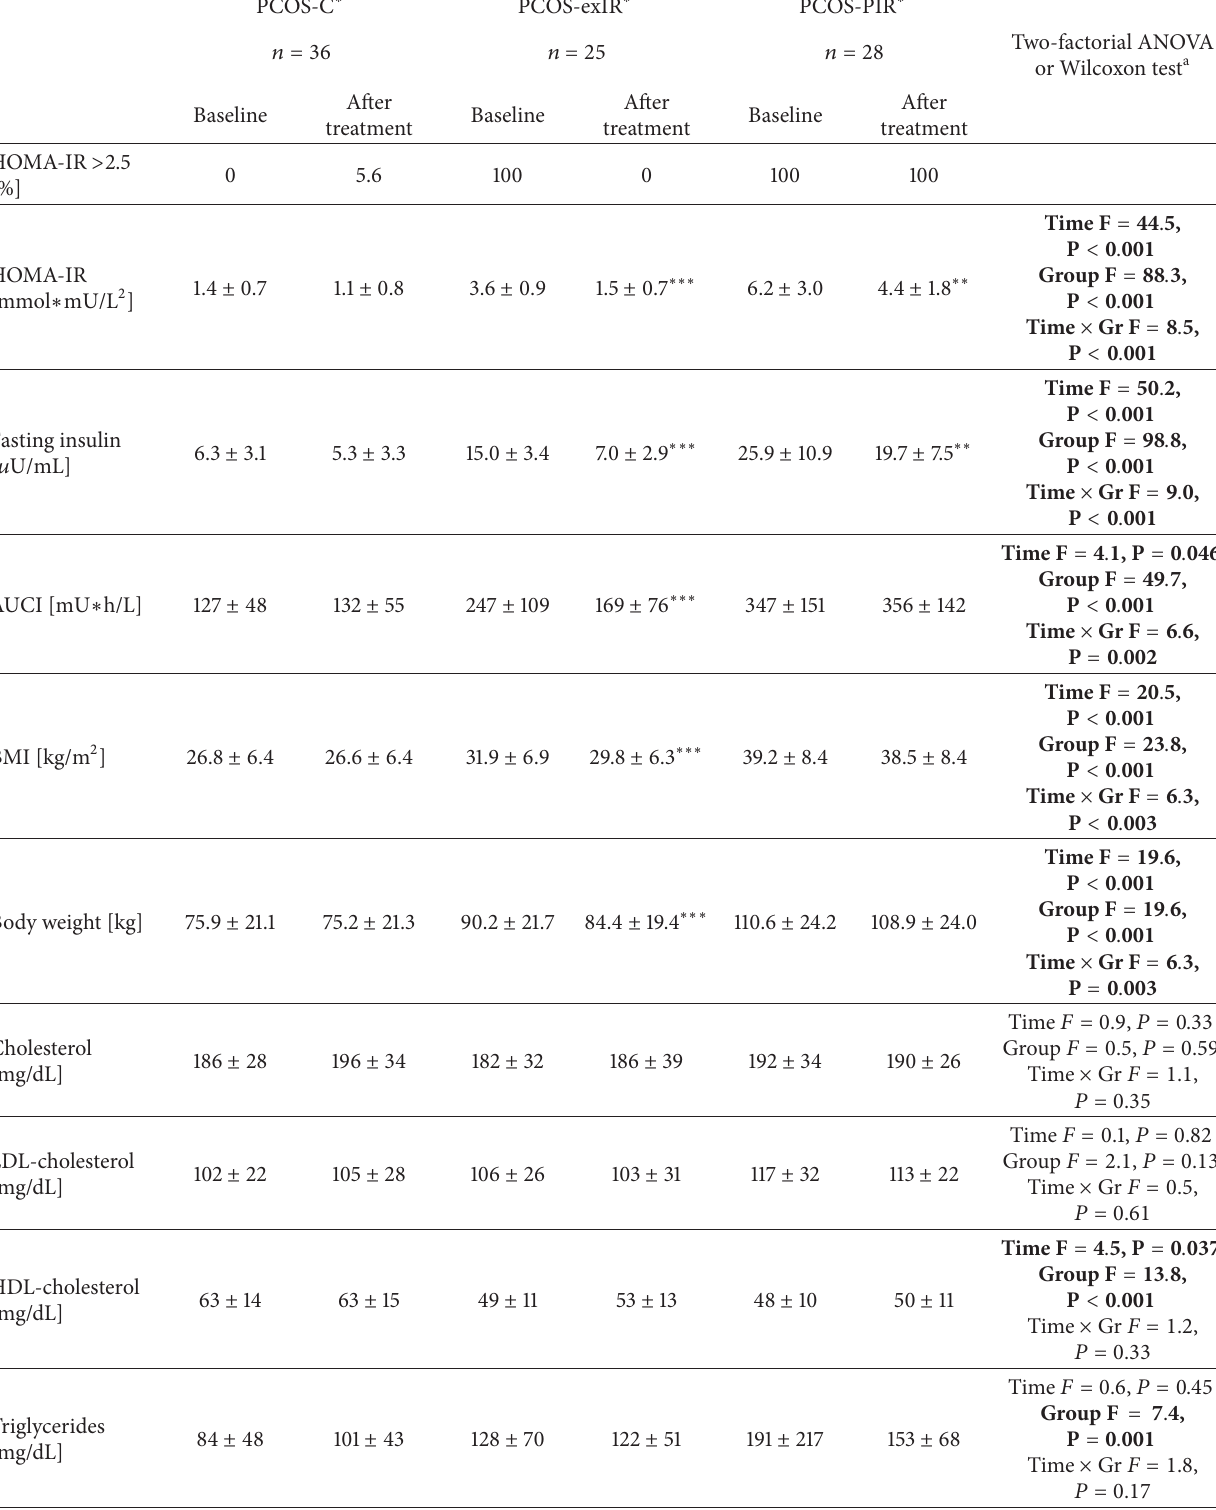
Table 2: Outcome parameters at baseline and after 6-month metformin treatment for patients with PCOS who were insulin sensitive at baseline (PCOS-C), patients with IR at baseline and after treatment (PCOS-PIR), and initially insulin resistant patients whose IR dissolved after treatment